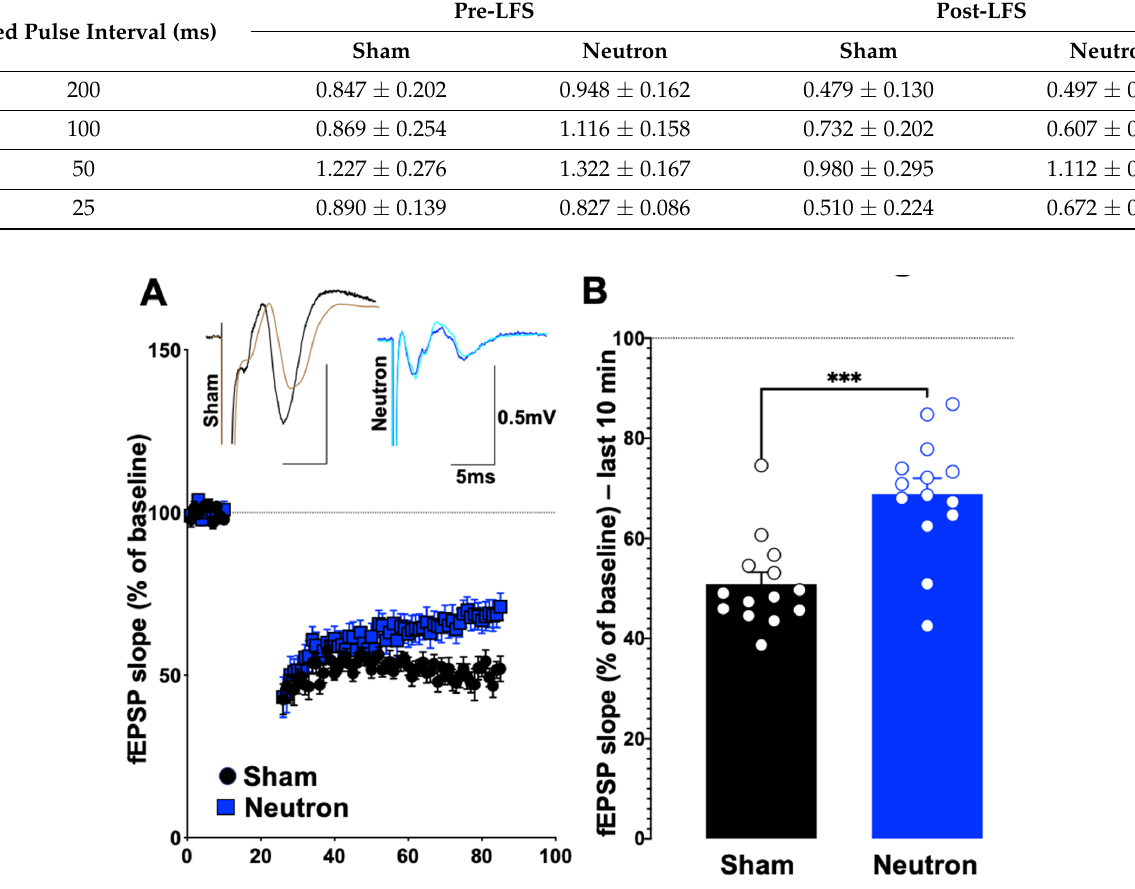
Figure 1. Chronic low dose neutron irradiation shows significant deficits in the low frequency stimulation associated long-term depression. ( A ) Stimulation of layer 2/3 and recording from the synapses to layer 5 using a low frequency stimulation (900 × 1 Hz) was performed in irradiated (blue circles) and age-matched sham mice (black circles). After a 10-min baseline, the LFS was performed for 15 min, following which LTD was measured for 60 min and plotted as fEPSP slope. ( B ) LFS-LTD (measured as average of last 10 min) in chronic low dose neutron irradiated mice (blue bar, 68.8 ± 3.137, n = 14) was significantly decreased (*** p = 0.0006, non-parametric, unpaired t -test, Mann–Whitney test) compared to control (black bar, 50.90 ± 2.375, n = 14). Representative traces are provided along with where the black trace show the pre-stimulation trace for control, while brown shows the post-stimulation trace. Blue shows the pre-, while pale green trace shows the post-stimulation trace for neutron-irradiated